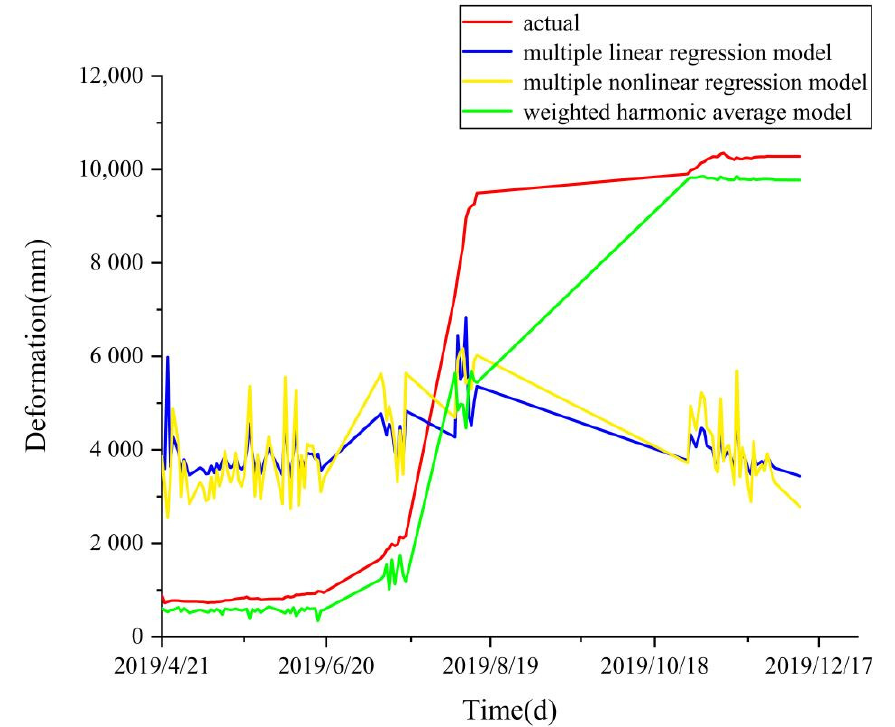
Figure 5. The comparing results of combination model, multiple linear regression model, and multiple nonlinear regression model.